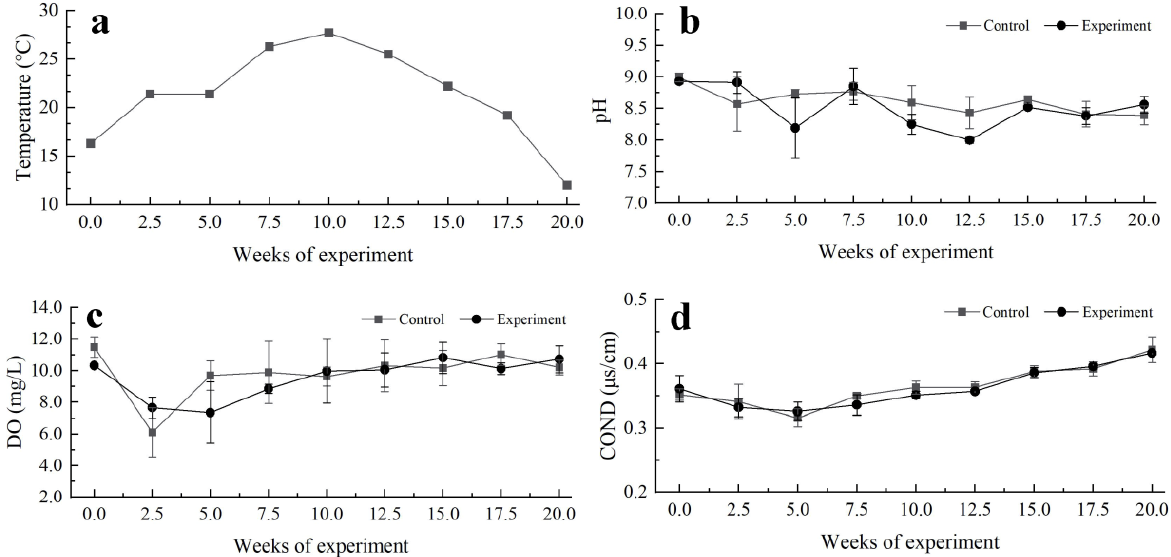
Figure 1. Changes of water quality parameters in the control and treatment group during the experiment. ( a ) Temperature; ( b ) pH; ( c ) DO; ( d ) COND. Vertical bars represent the mean ± SD ( n = 3).